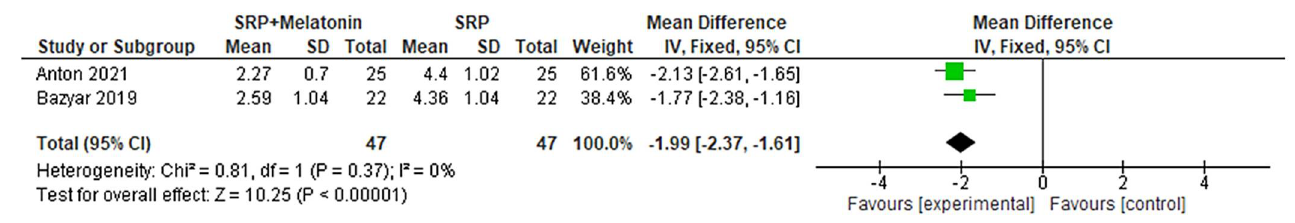
Figure 3. Meta-analysis of adjunctive application of melatonin on periodontal non-surgical therapy; comparison: adjunctive application of melatonin with scaling and root planing versus scaling and root planing alone; outcome: periodontal pocket depth at 8 weeks after the procedure.